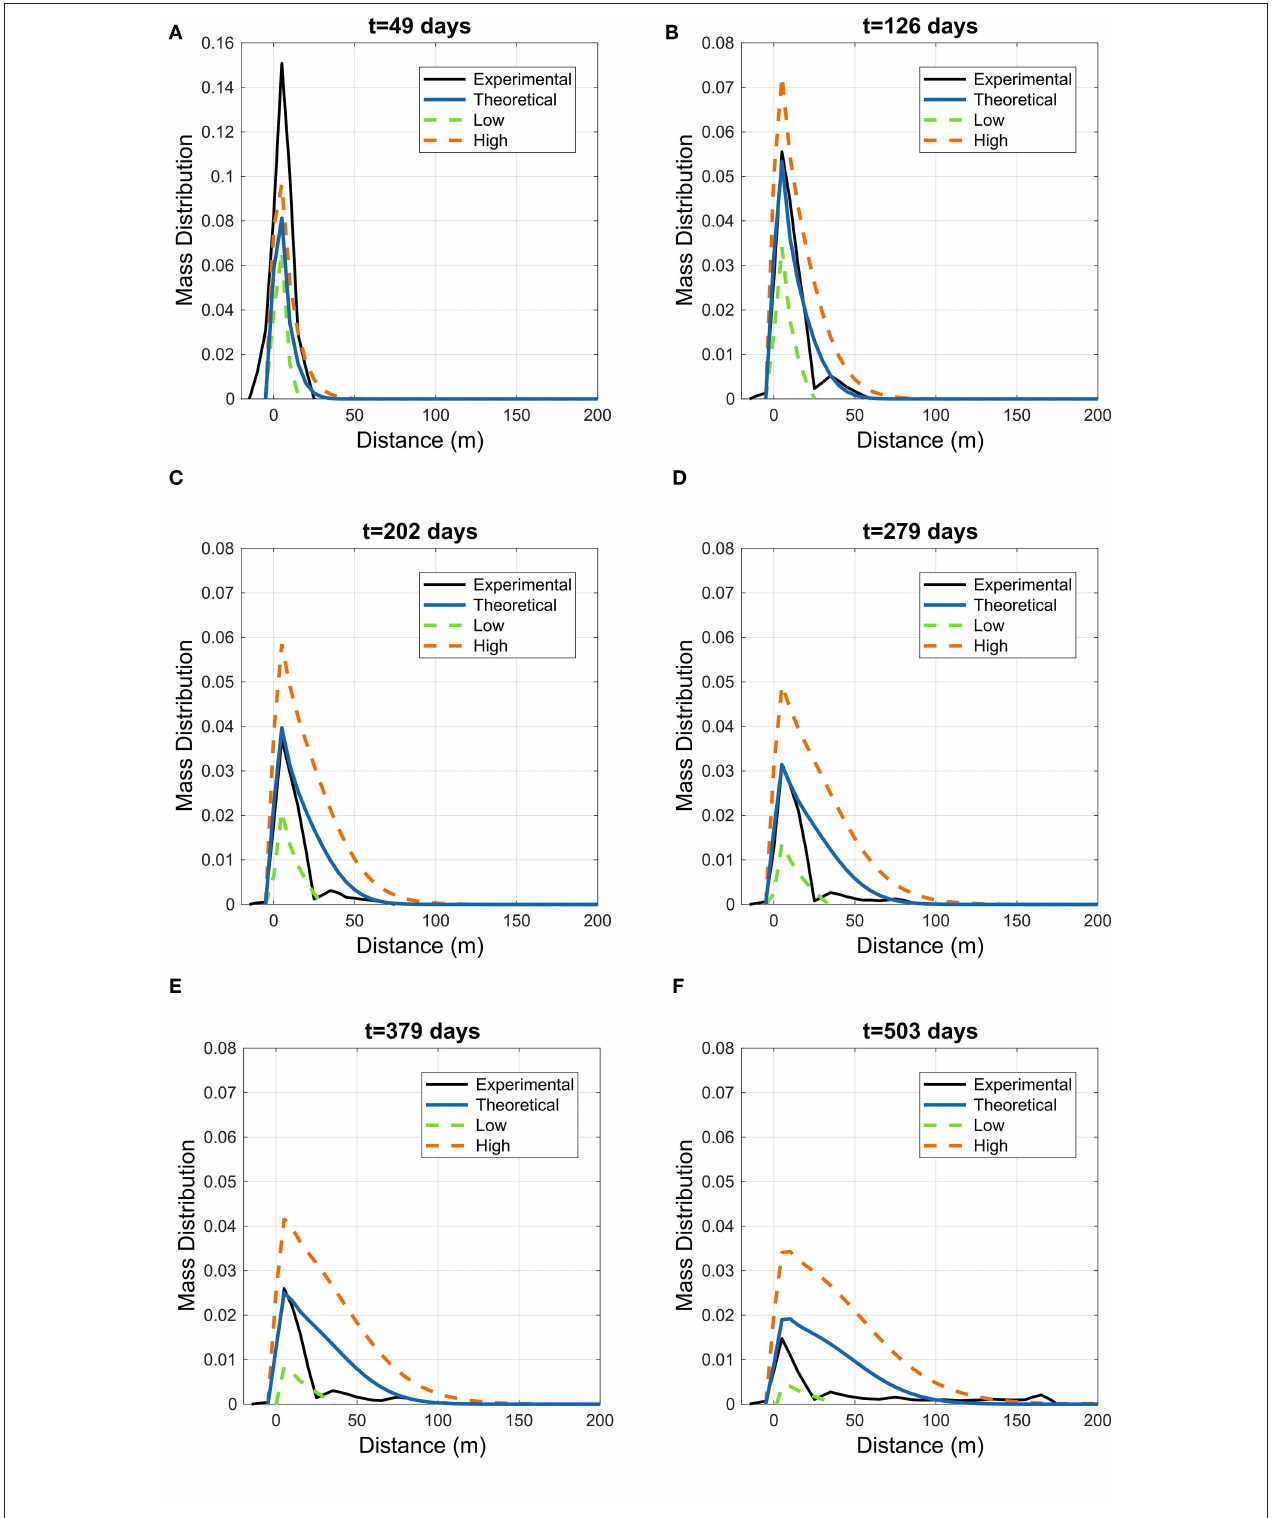
FIGURE 5 | Uncertainty due to non-ergodic effects: the experimental longitudinal mass distribution at the MADE-1 experiment for the six snapshots presented by Adams and Gelhar (1992); black lines); the blue solid line depicts the theoretical m ( x ; t ) (15), while the dashed lines represent the bounds for non-ergodicity uncertainty m + σ m (orange dashed line, “High”) and m − σ m (green dashed line, “Low”). G 1 in solutions (15) is given by (C.3). Mass recovery in the experiments was 206, 99, 68, 62, 54, and 43% at snapshots t = 49,126,202,279,370,503 days, respectively.